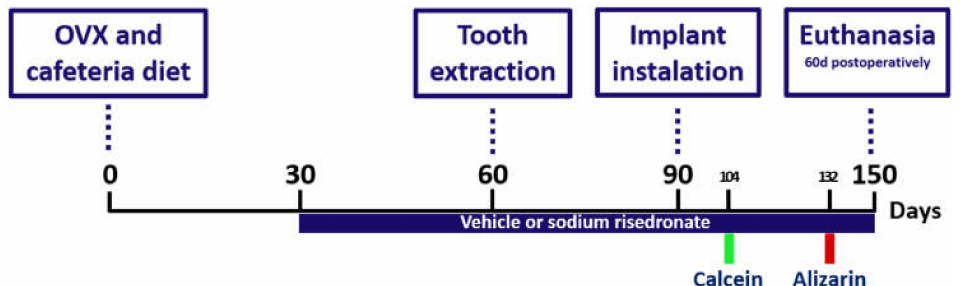
Figure 1. Scheme illustrating the experimental design according to the procedures performed in the study.